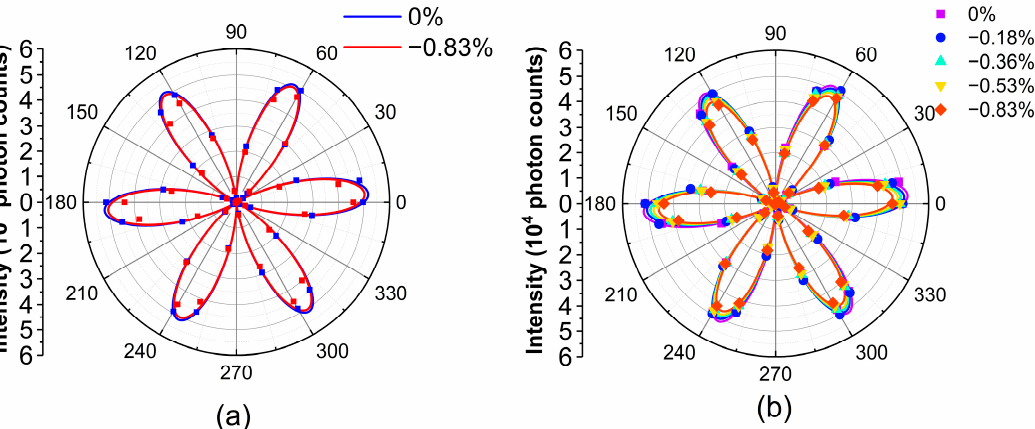
Figure 5. ( a ) The experimental results in dots and the calculated curves in solid lines from the model based on the first-principles methods without a correction parameter. ( b ) The calculated curves with a correction parameter to linearly modify the strain term.